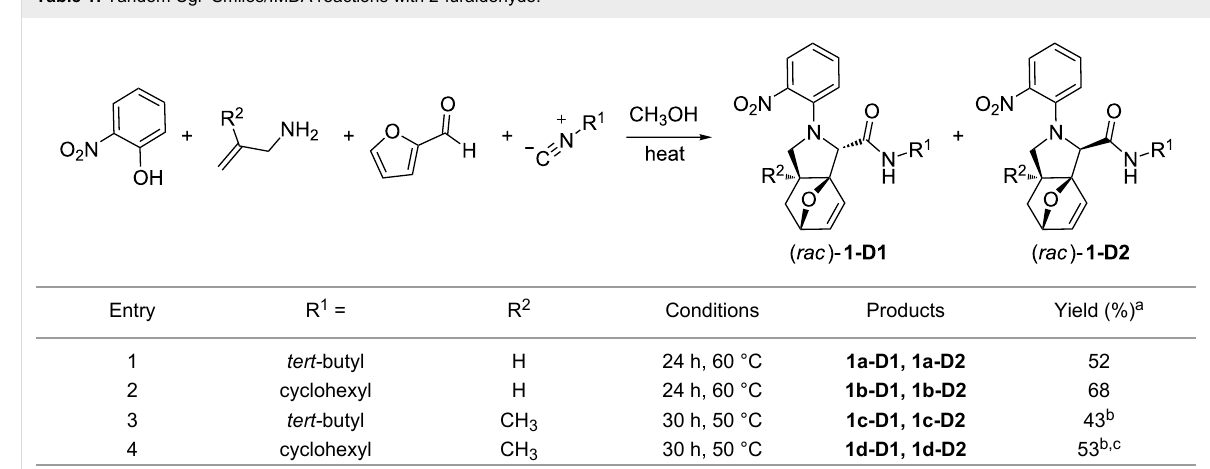
Table 1: Tandem Ugi–Smiles/IMDA reactions with